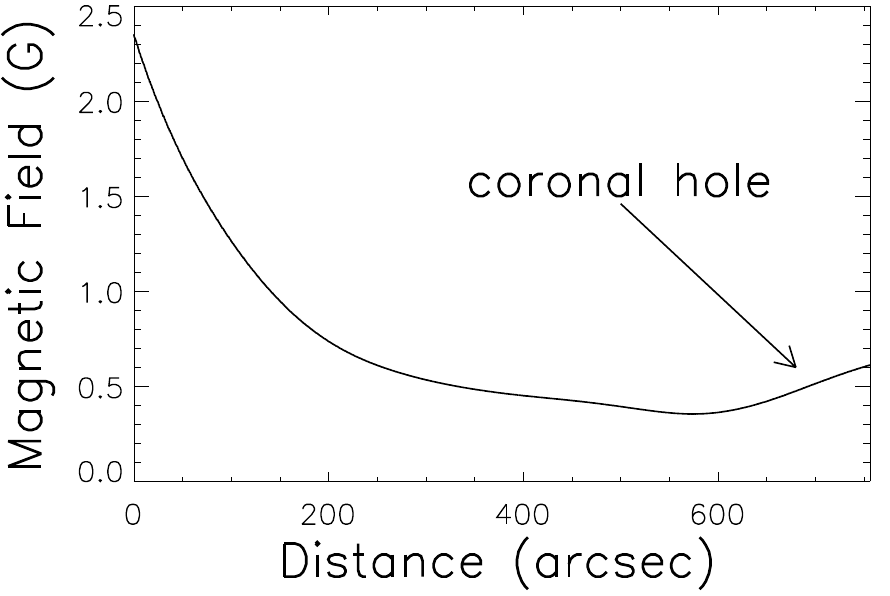
Figure 5. Distribution of the magnetic field strength at the altitude of 0.1 R (cid:12) along the slice S 1